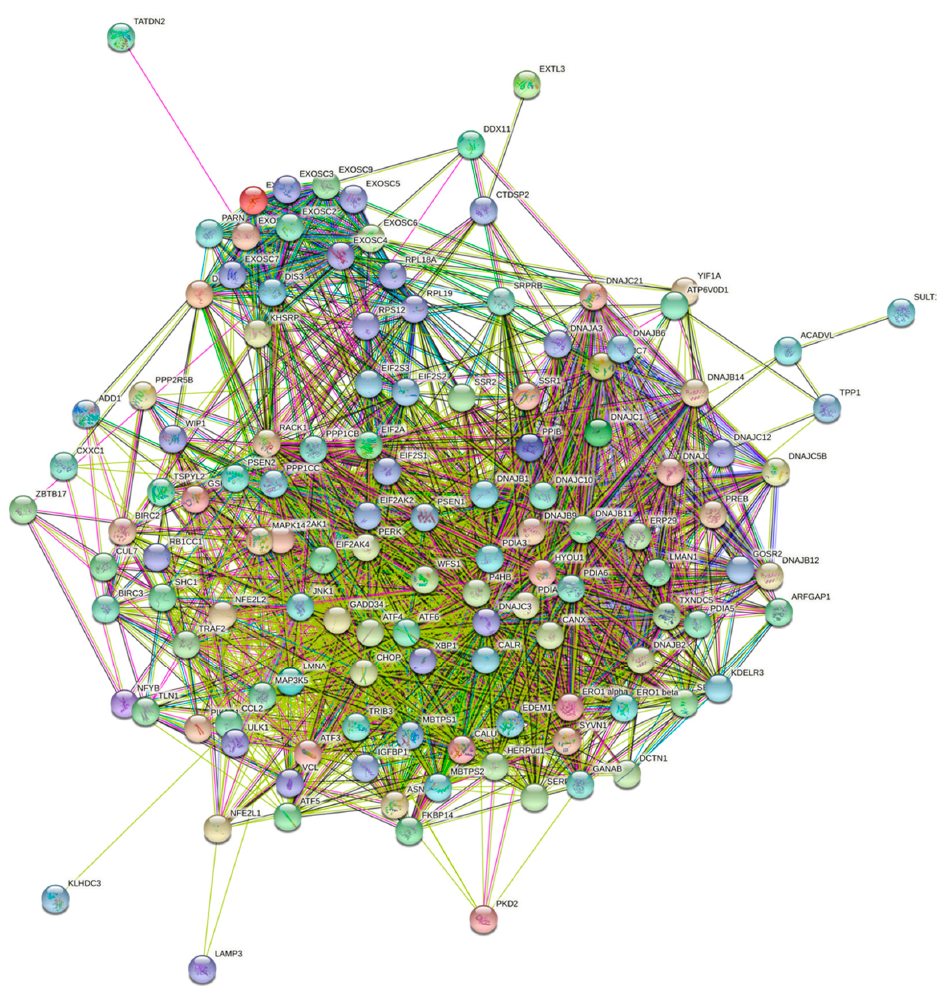
Figure 2. An interconnected gene map of the entire UPR-associated gene-set derived from STRING and the Harmonizome.